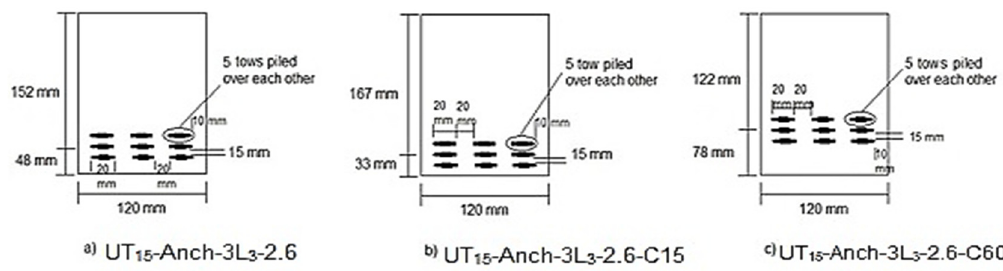
Figure 20. Details of different cover thicknesses in ( a ) UT 15 -Anch-3L 3 -2.6 ( b ) UT 15 -Anch-3L 3 -2.6-C15 and ( c ) UT 15 -Anch- 3L 3 -2.6-C60 TRC beams.